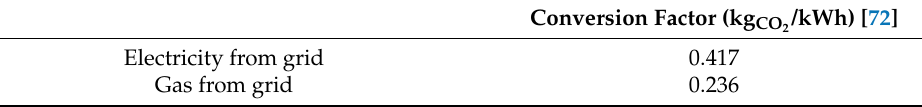
Table 9. CO 2 conversion factors used in calculations.